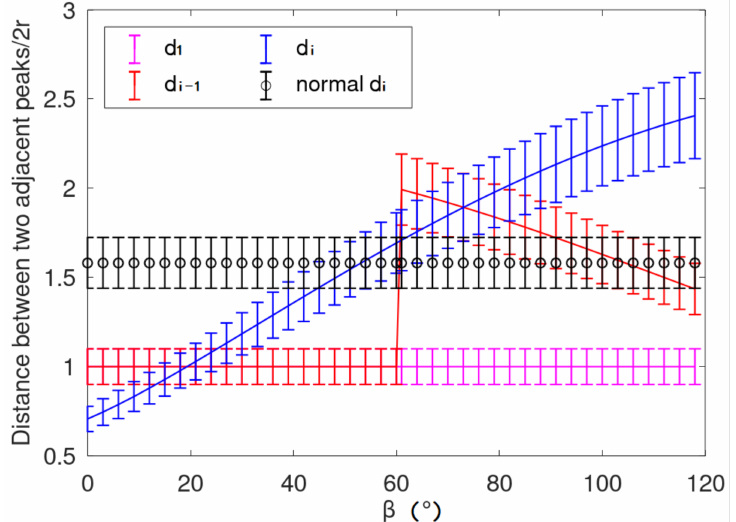
Figure 16. Distance between the two adjacent peaks. The mean distance between the two adjacent peaks is 2 × r as d 1